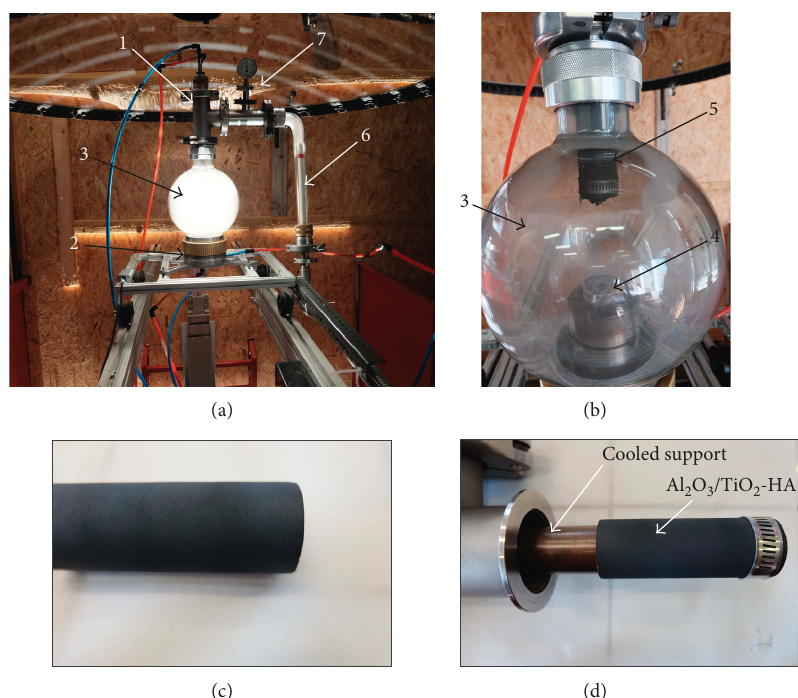
Figure 1: (a) Experimental setup used for the solar synthesis of palladium-doped carbon nanoparticles; (b) detail of the solar reactor; (c, d) ceramic-metallic catalyst. (1) Water-cooled system of the ceramic catalyst, (2) water-cooled support for the Pd/C target, (3) Pyrex glass reactor, (4) target positioned on the cooled support, (5) catalyst, (6) vacuum extraction and ceramic filter, and (7) manometer.